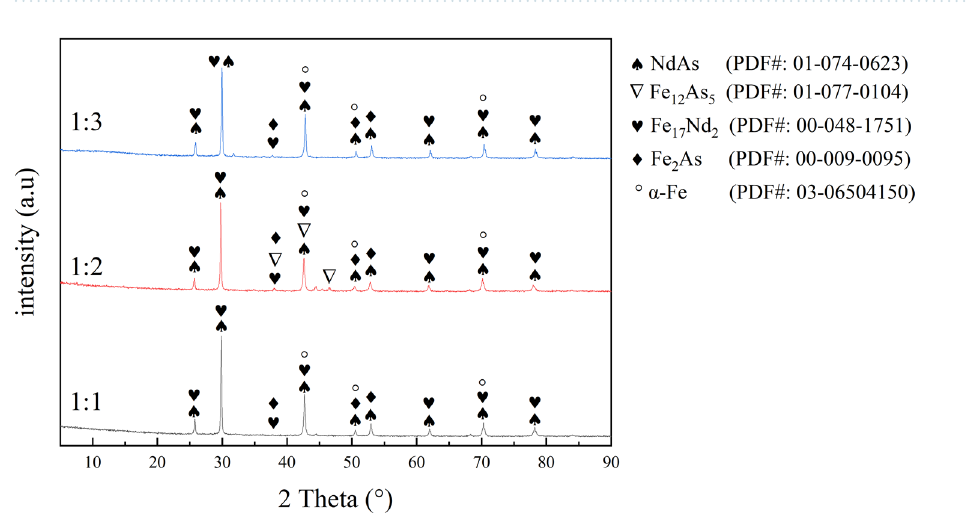
Figure 3. X-ray diffraction spectra of the samples at different atomic